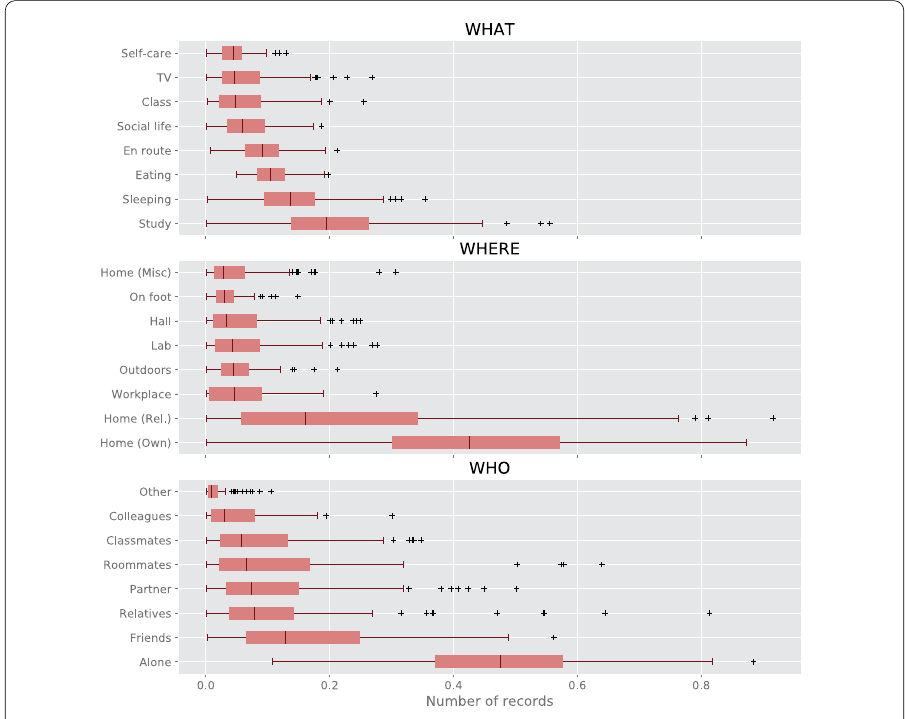
Figure 4 Value distribution of different aspects. From top to bottom: WA, WE, and WO. Only the eight most frequent annotations are shown for each aspect. The boxes extend from the 1st to the 3rd quartiles, while the bars extend to ± 1.5 inter-quartile range from the median. Study participants with very high annotation frequency (i.e. outliers) are denoted by